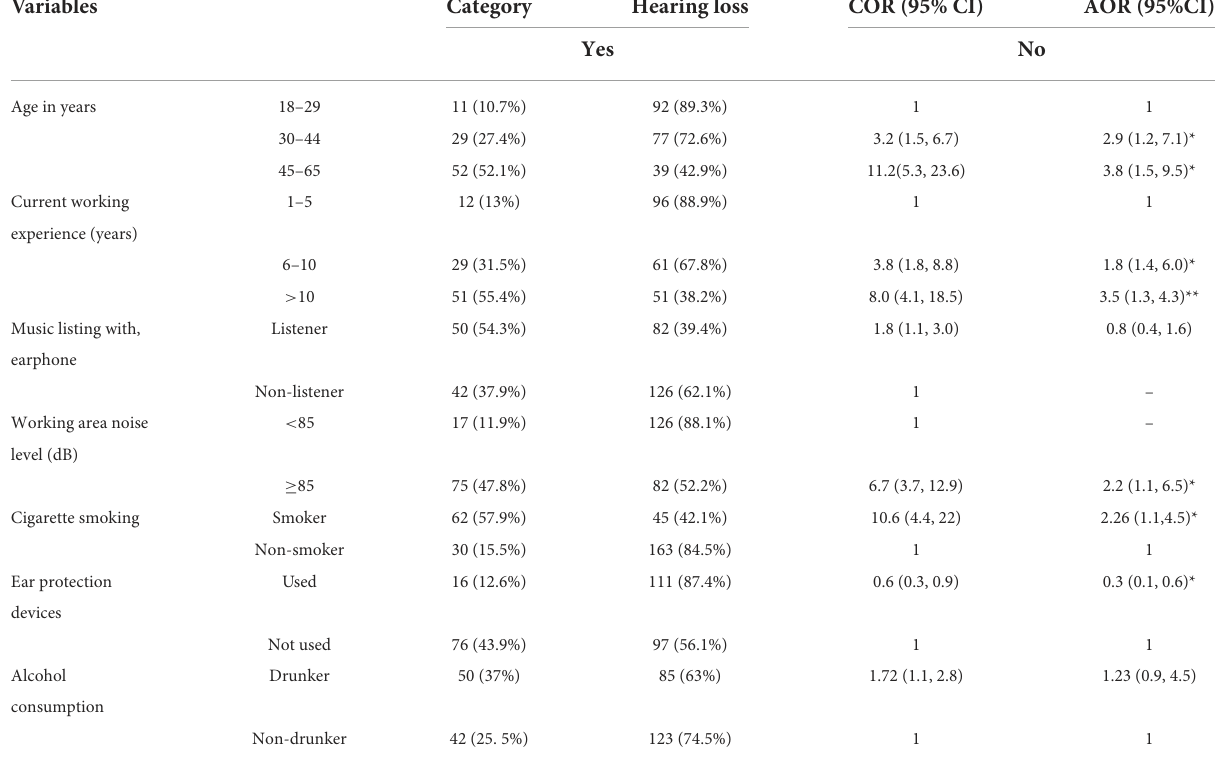
TABLE 3 Factors associated with hearing loss among metal workshop workers in Gondar city, Northwest Ethiopia, 2021.